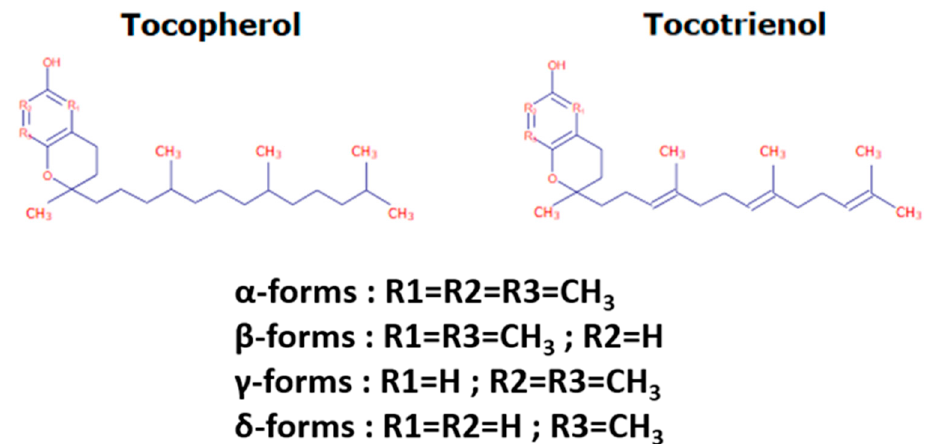
Figure 1. Tocochromanol structure .